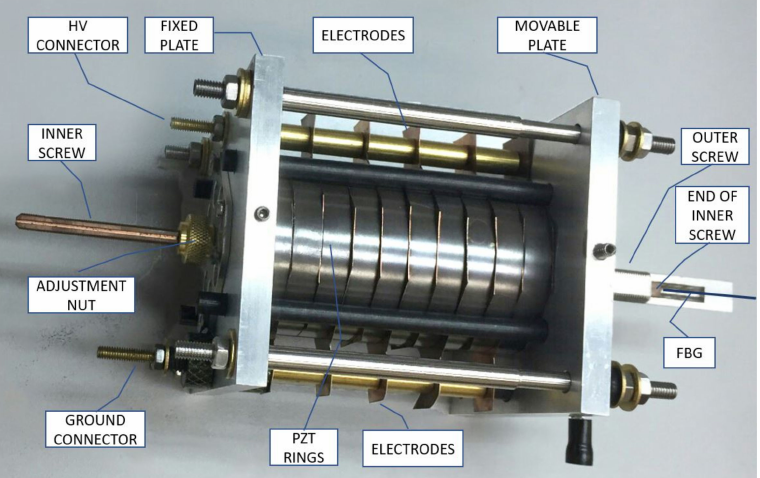
Figure 2. OVT mechanical structure with PZT ceramics stack. The FBG is bonded between the screw ends (adapted from [7] with permission).